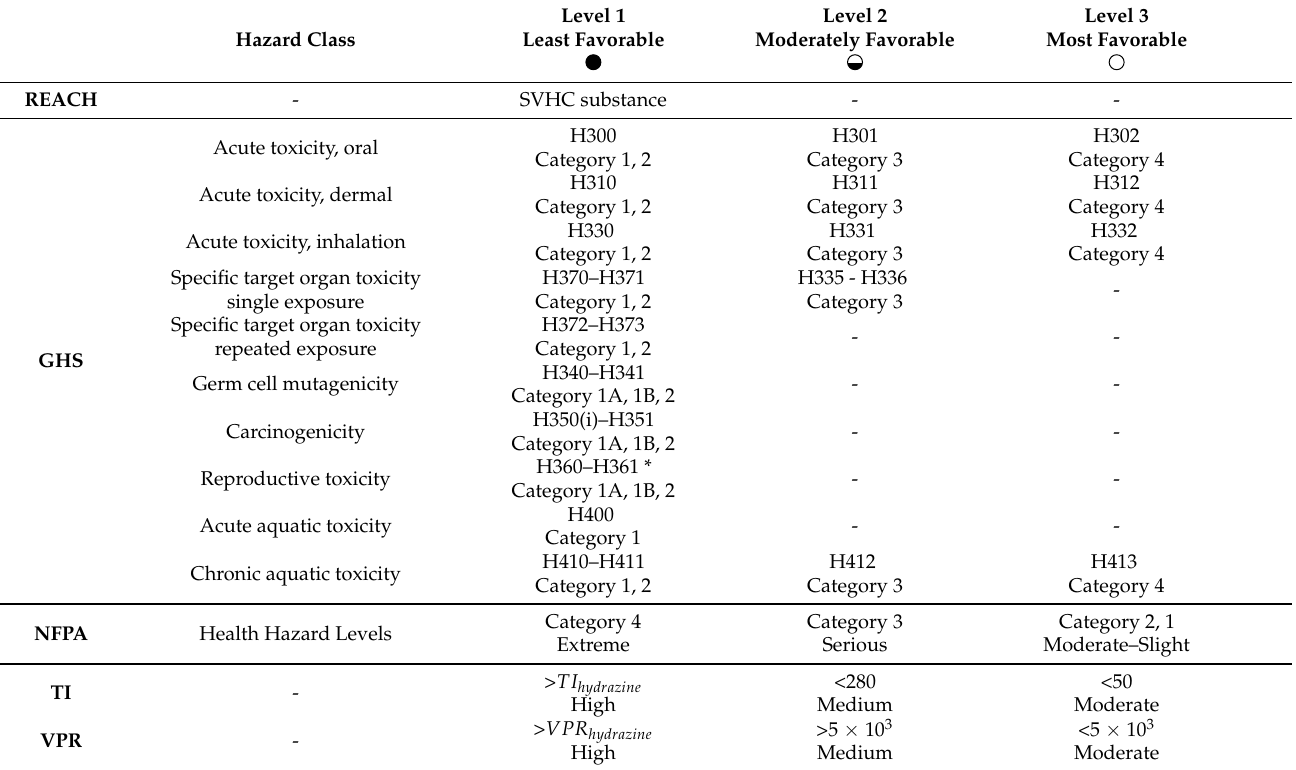
Table 6. cyanHealth hazards rating and